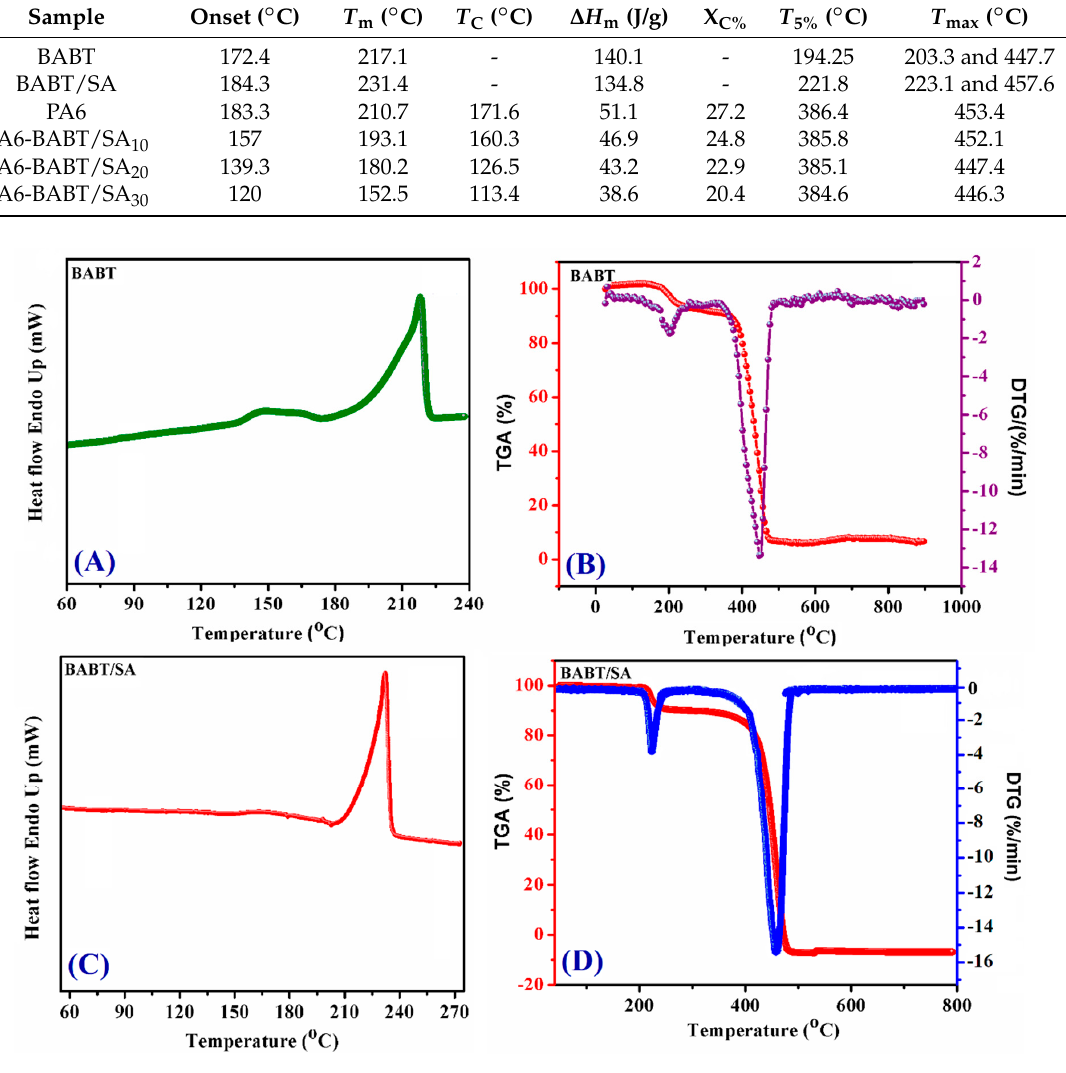
Figure 10. Differential scanning calorimetry (DSC) traces of ( A ) BABT and ( C ) BABT/SA salt; thermogravimetric analysis (TGA) of ( B ) BABT and ( D ) BABT/SA salt.